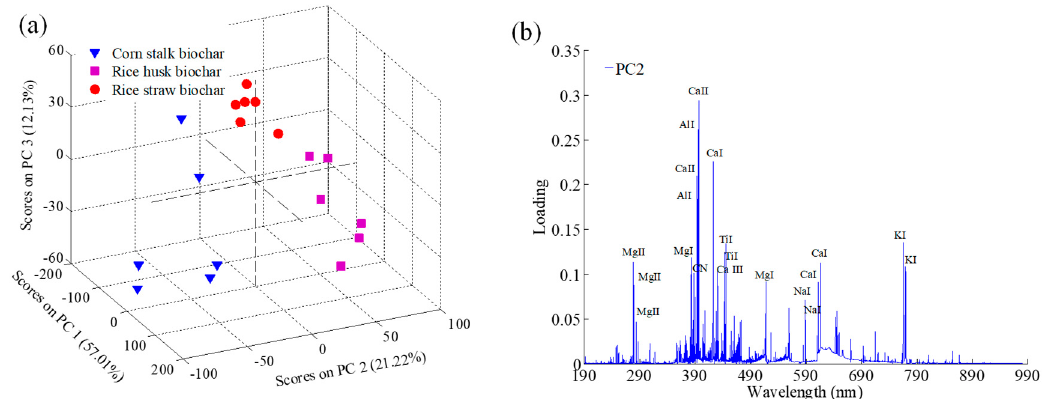
Figure 2. Score plot ( a ) and loading plot ( b ) of the first three principal components (PCs).